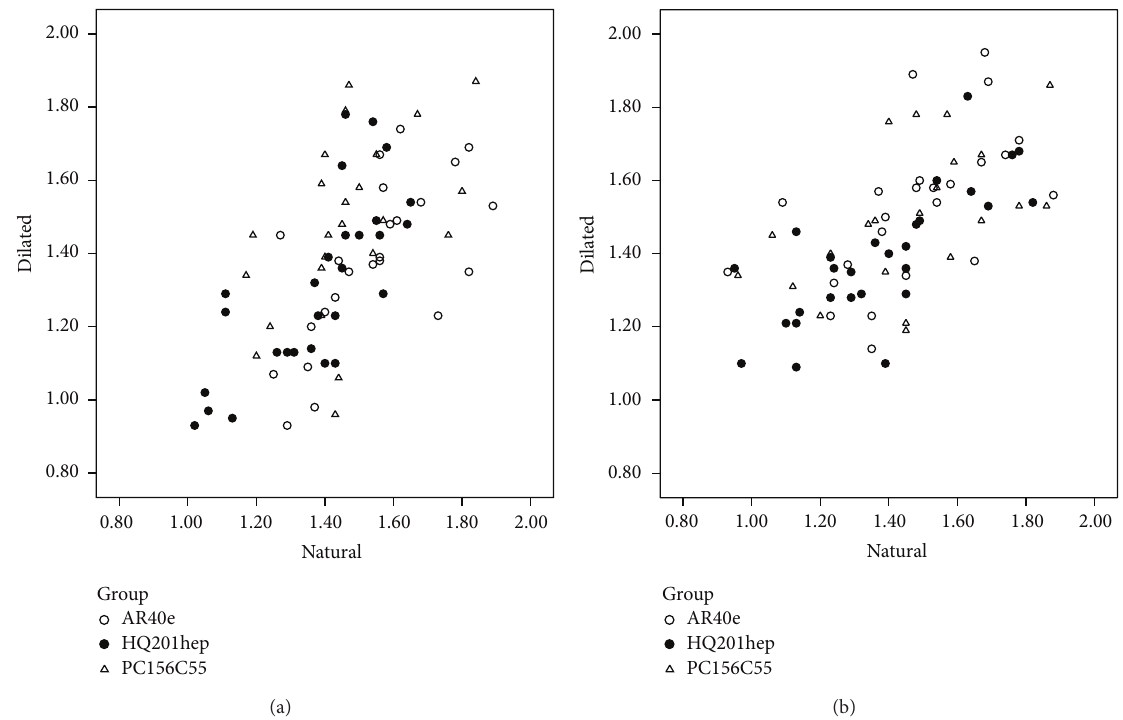
Figure 2: (a) The scatterplot of the straylight values of three IOLs before ( 𝑥 -axis) and after ( 𝑦 -axis) pupil dilation one week after surgery. (b) The scatterplot of the straylight values of three IOLs before ( 𝑥 -axis) and after ( 𝑦 -axis) pupil dilation one month after